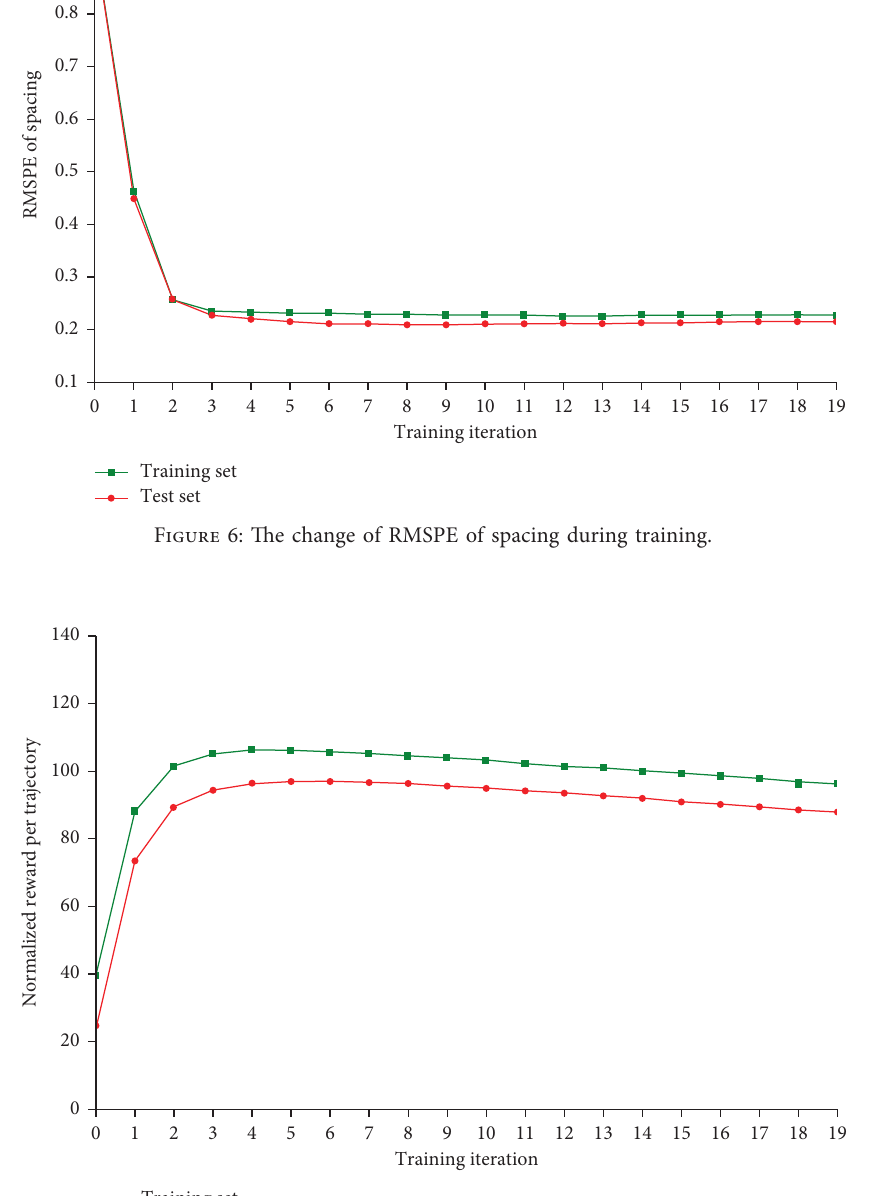
Figure 7: The change of the normalized reward accumulated in every trajectory during training.